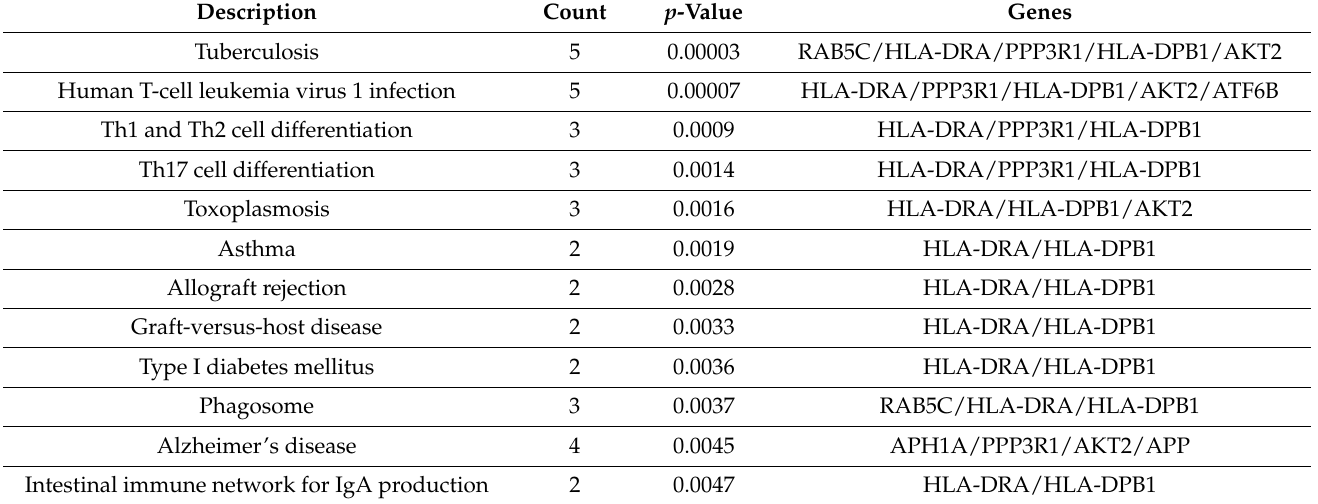
Table 3. Kyoto Encyclopedia of Genes and Genomes pathway analysis of the dysregulated genes (top 20) identified in breast cancer